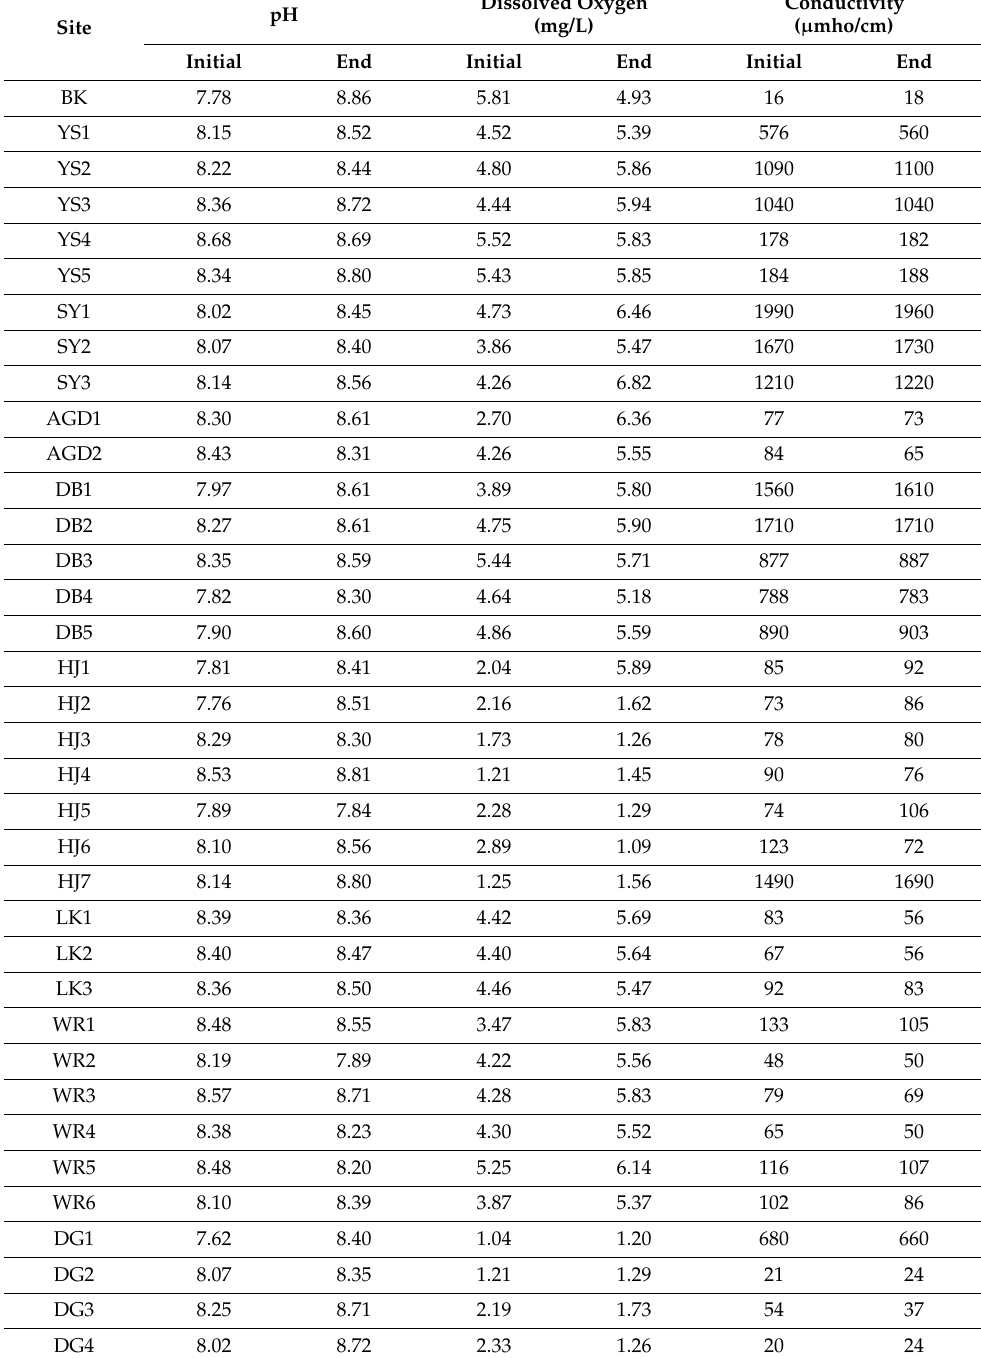
Table 3. pH, dissolved oxygen, and conductivity in sediment porewaters during toxicity